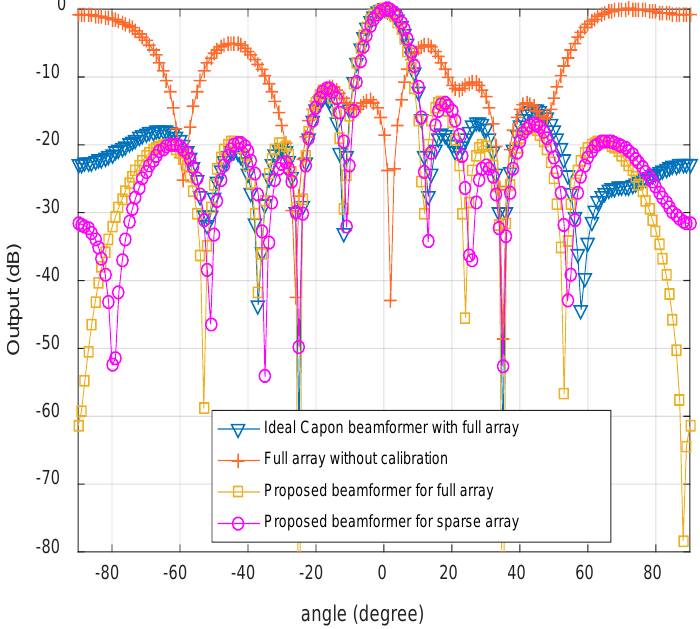
Figure 2. Beampatterns comparison.